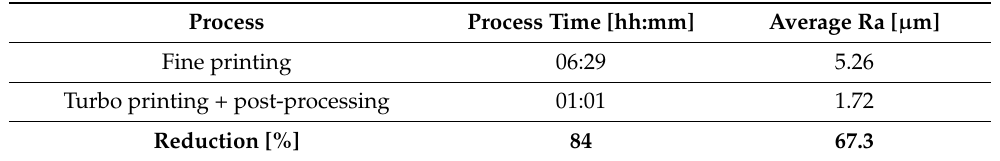
Table 7. Difference between the fine 3D printing strategy and laser polishing post-processing solution (ED = 1.27 J/mm 2